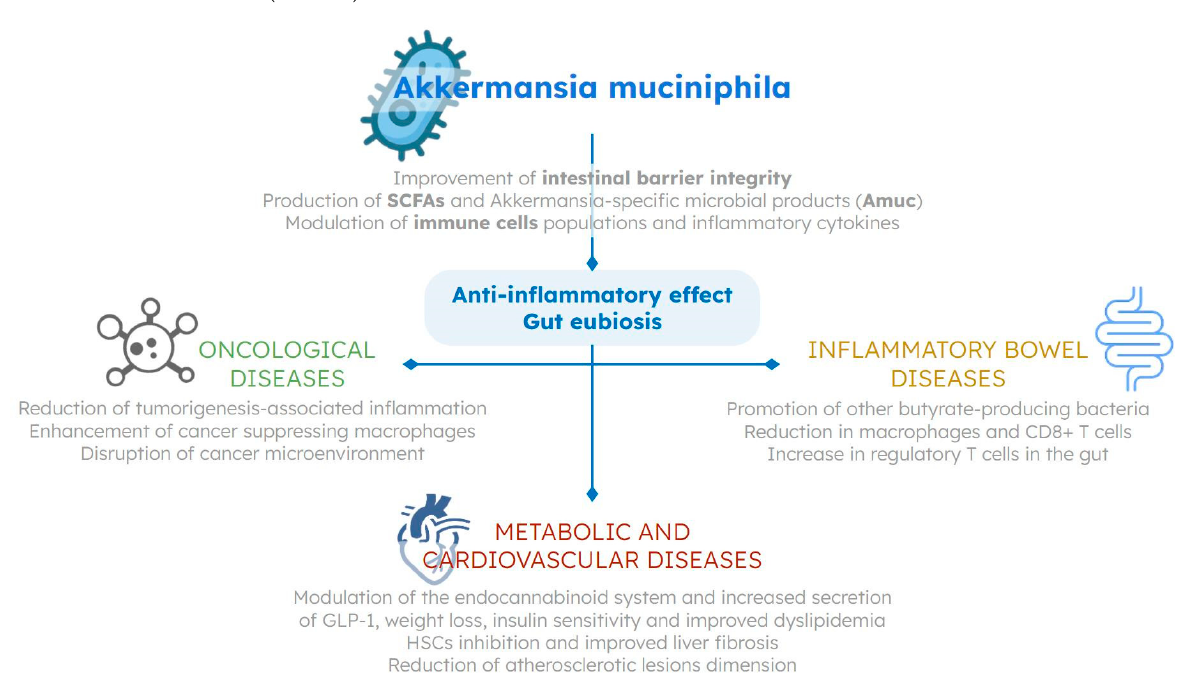
Figure 1. Potential beneficial mechanisms of Akkermansia muciniphila in humans. Through the direct and indirect regulation of immune system response, inflammatory, and endocrine pathways, as well as its substantial influence on gut ecology, Akkermansia muciniphila has been proven to have a beneficial role in modulating intestinal and extraintestinal diseases. HSCs—hepatic stellate cells; GLP-1—glucagon-like peptide-1; SCFAs—short-chain fatty acids.